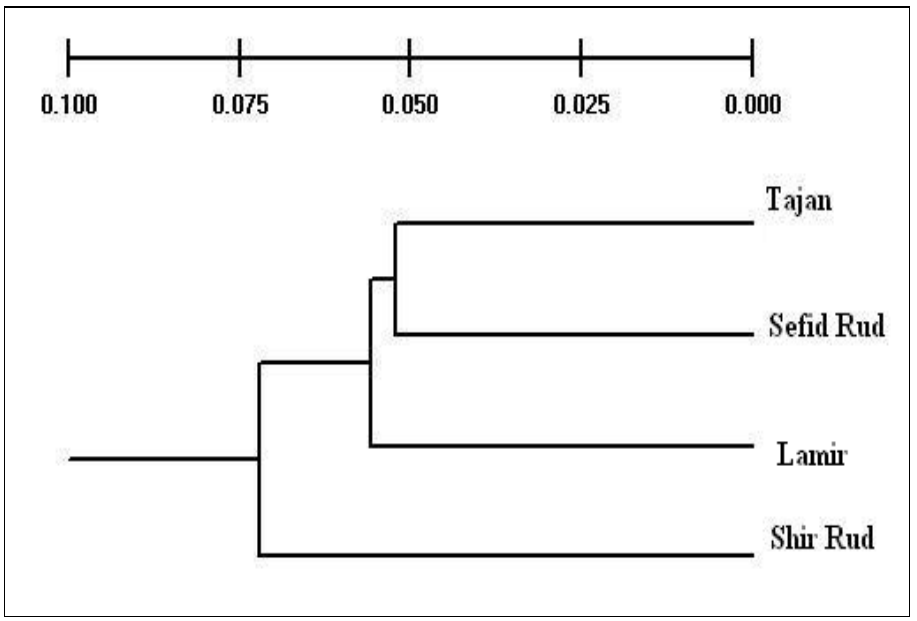
F IGURE 2. UPGMA dendrogram based on the Nei (1978) genetic distance between Rutilus frisii kutum populations, based on microsatellite DNA